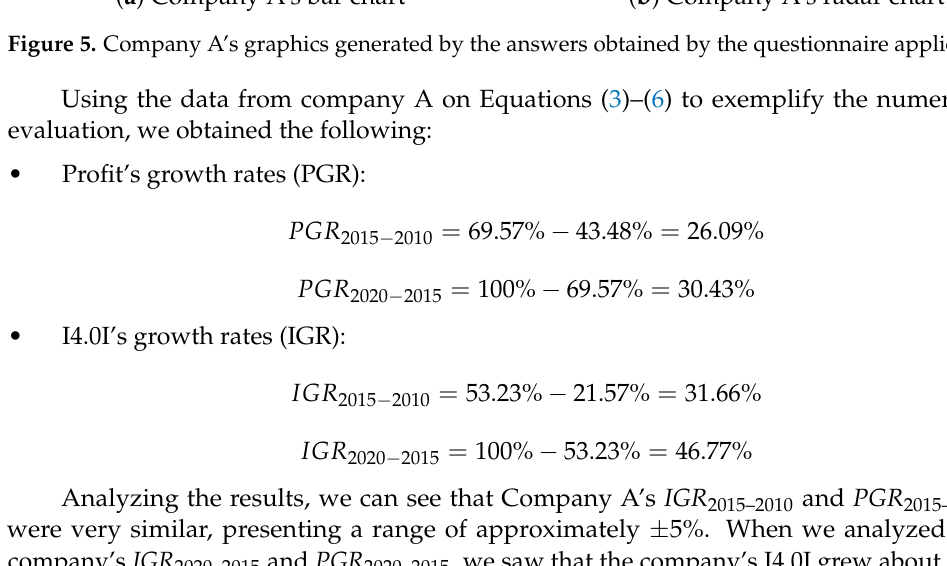
Figure 5. Company A’s graphics generated by the answers obtained by the questionnaire